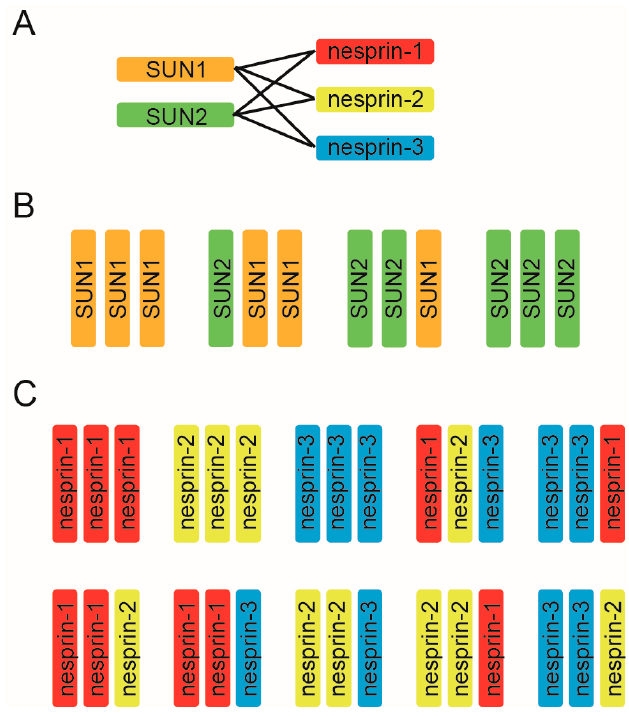
Figure 2. The compositional nature of the SUN–KASH hetero-hexamer. ( A ) The SUN–KASH combination is promiscuous. In mammalian somatic cells, except for the secretory epithelia, there are six combinations possible for two SUN proteins and three nesprins; ( B ) Mammalian cells mainly express SUN1 and SUN2 protein in somatic cells. SUN1 and SUN2 homo- and hetero-trimeric arrangement is conceivable; thus, four combinations of SUN trimers are possible; ( C ) Possible combinations of nesprin protein trimers using nesprin-1, nesprin-2, and nesprin-3, which are expressed in mammalian somatic cells.